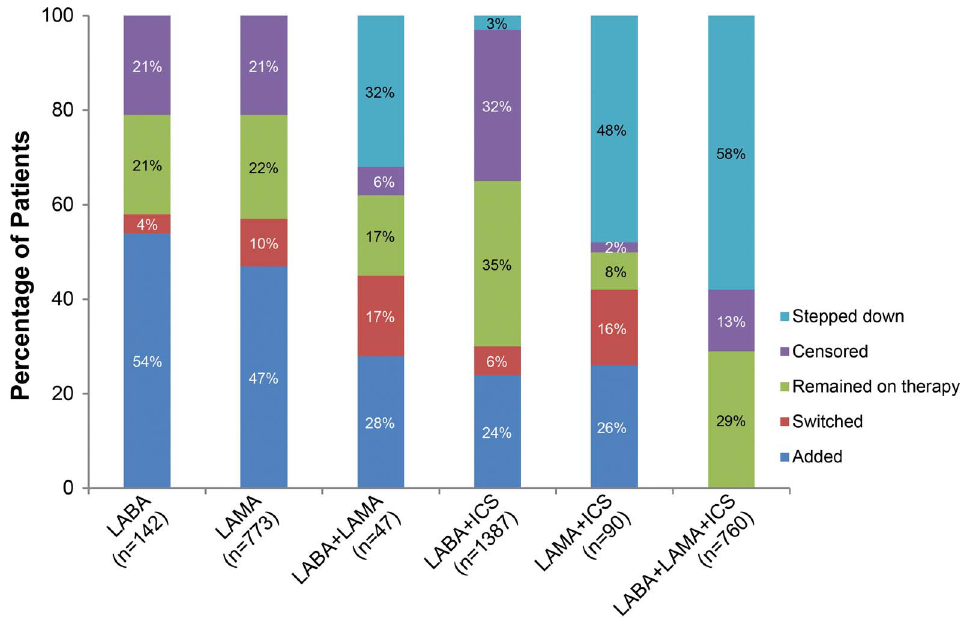
Figure 3. Percentage of changes in maintenance medications at the end of the 24 months of follow-up. Censored indicates no prescription for a COPD maintenance medication during a 3 month interval.